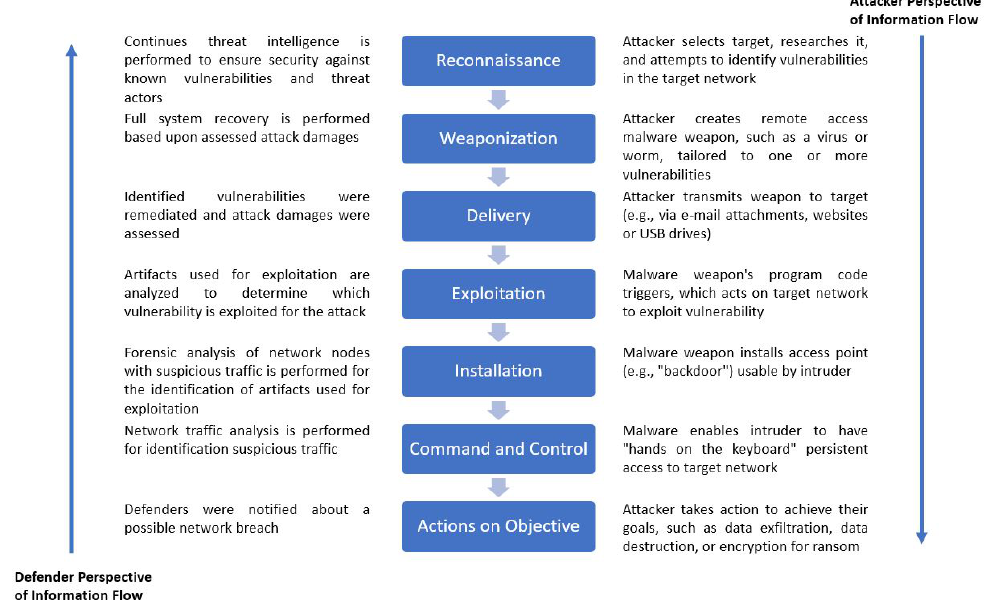
Figure 7. General attack and defence scenario using Cyber Kill